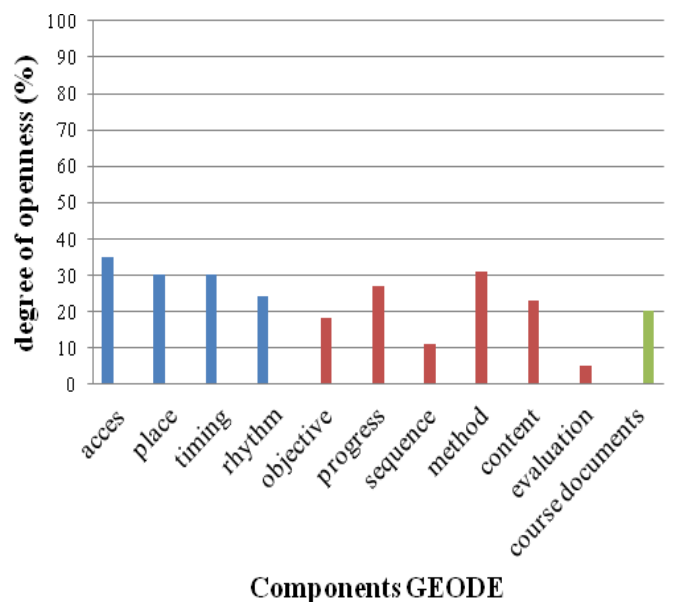
Graph 1. The eleven components presented a low degree of openness.